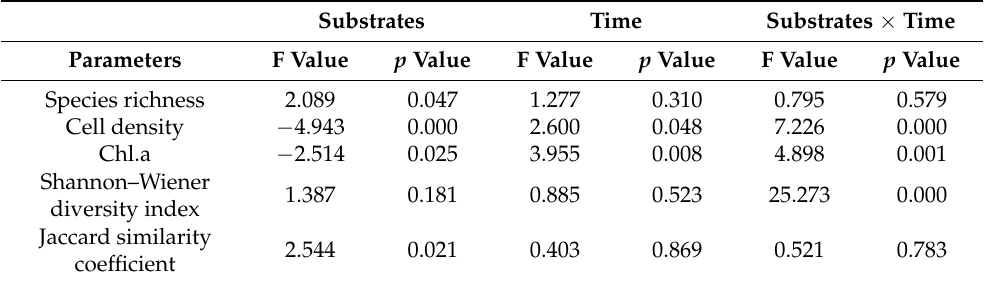
Figure 2. Periphytic-algae species richness: ( a ) At different lakes; and ( b ) on different substrates. Table 2. The effects of time and substrate on periphytic algae species richness and biomass.